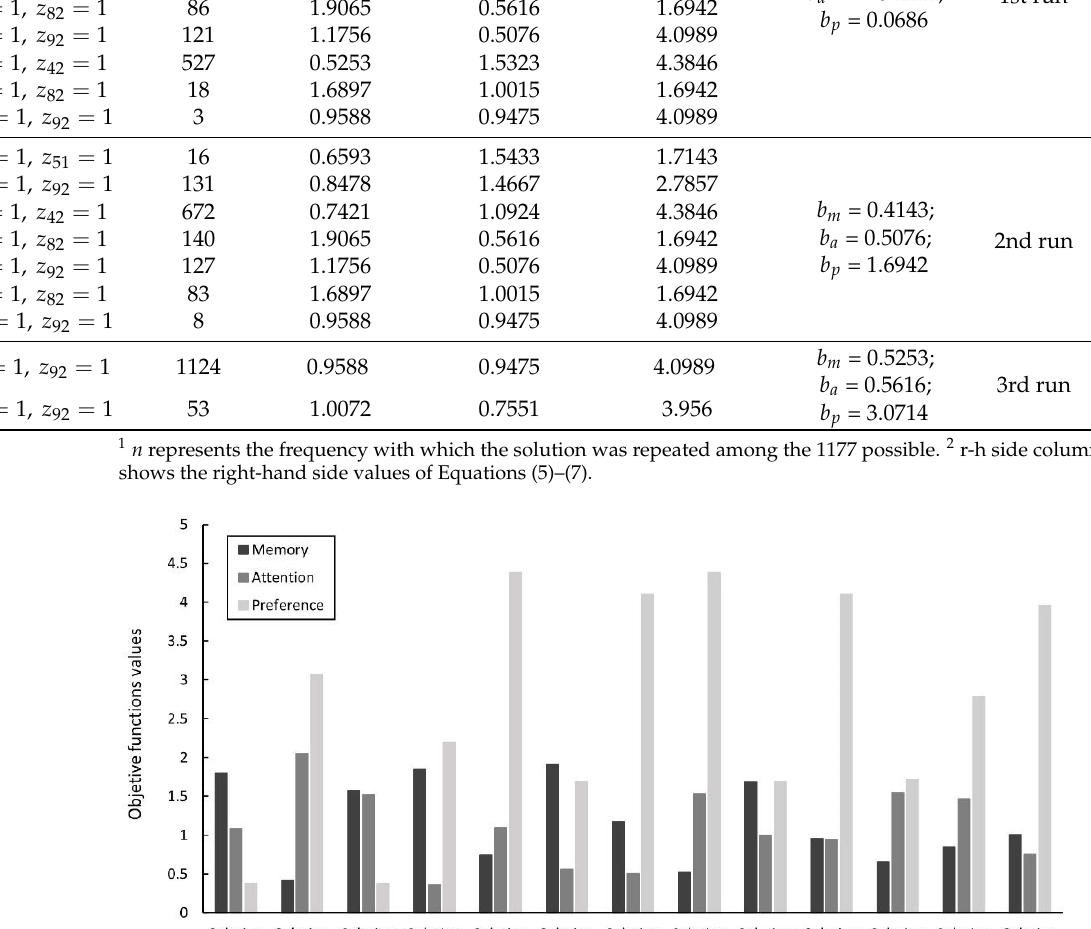
Figure 3. Levels of psychological metrics of each efficient solution.